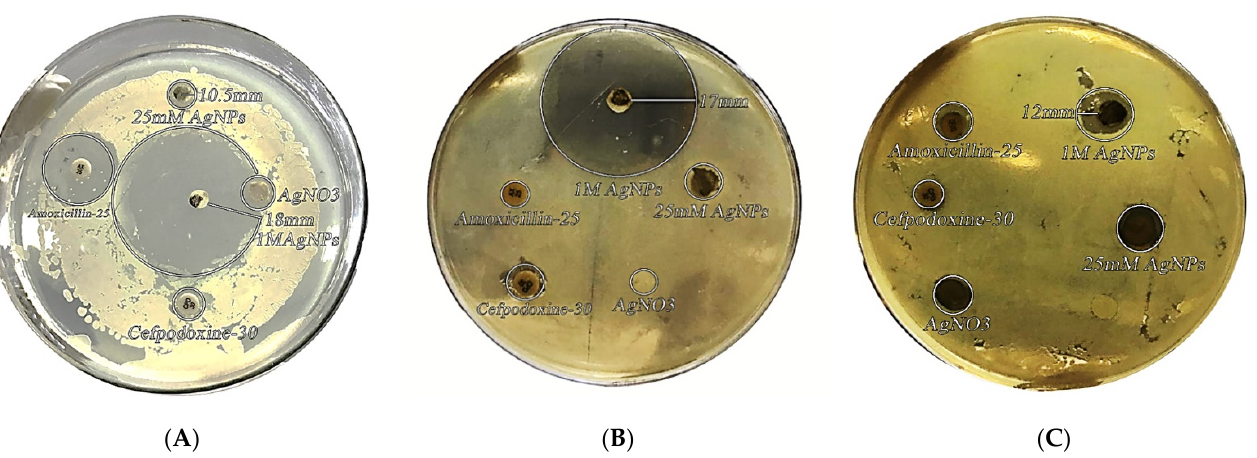
Figure 6. Bactericidal activity of biosynthesized AgNPs from Acer oblongifolium against ( A ) E. coli , ( B ) B. cereus , and ( C ) B. paramycoides .